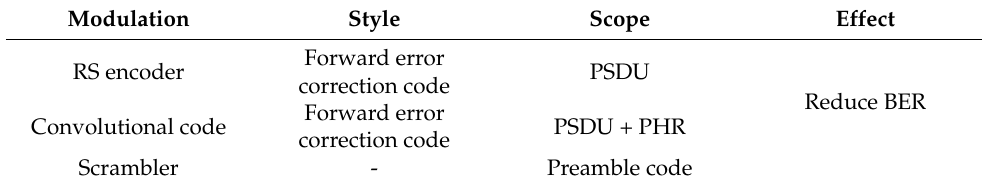
Table 1. Comparison between different